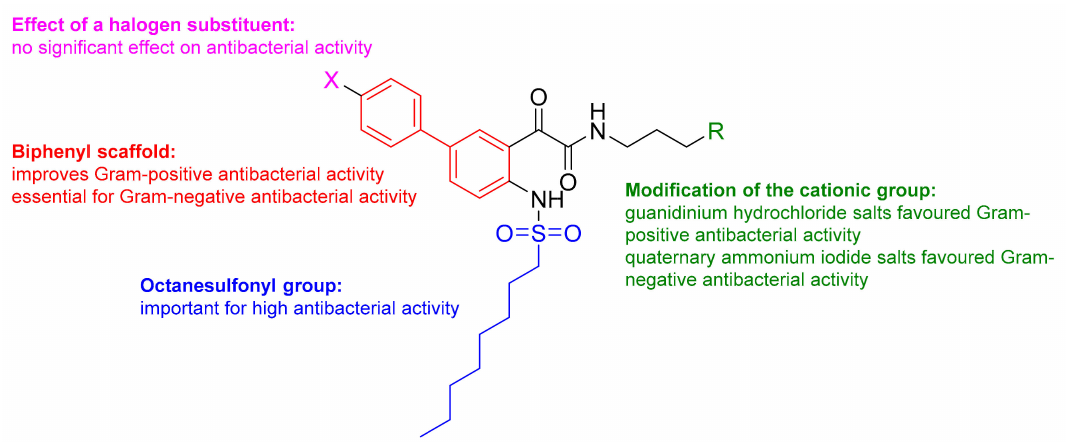
Figure 3. Summary of structure–activity relationships (SARs) for antibacterial